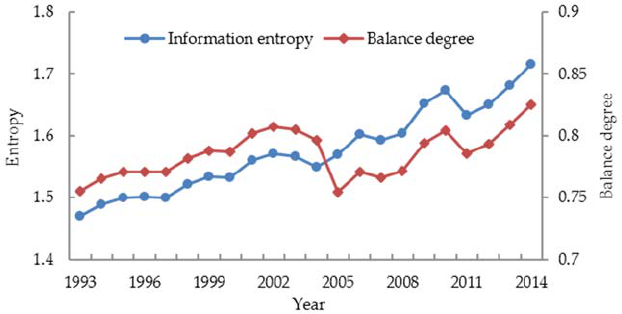
Figure 5. Changes in information entropy and the balance degree for water consumption in Nanjing.